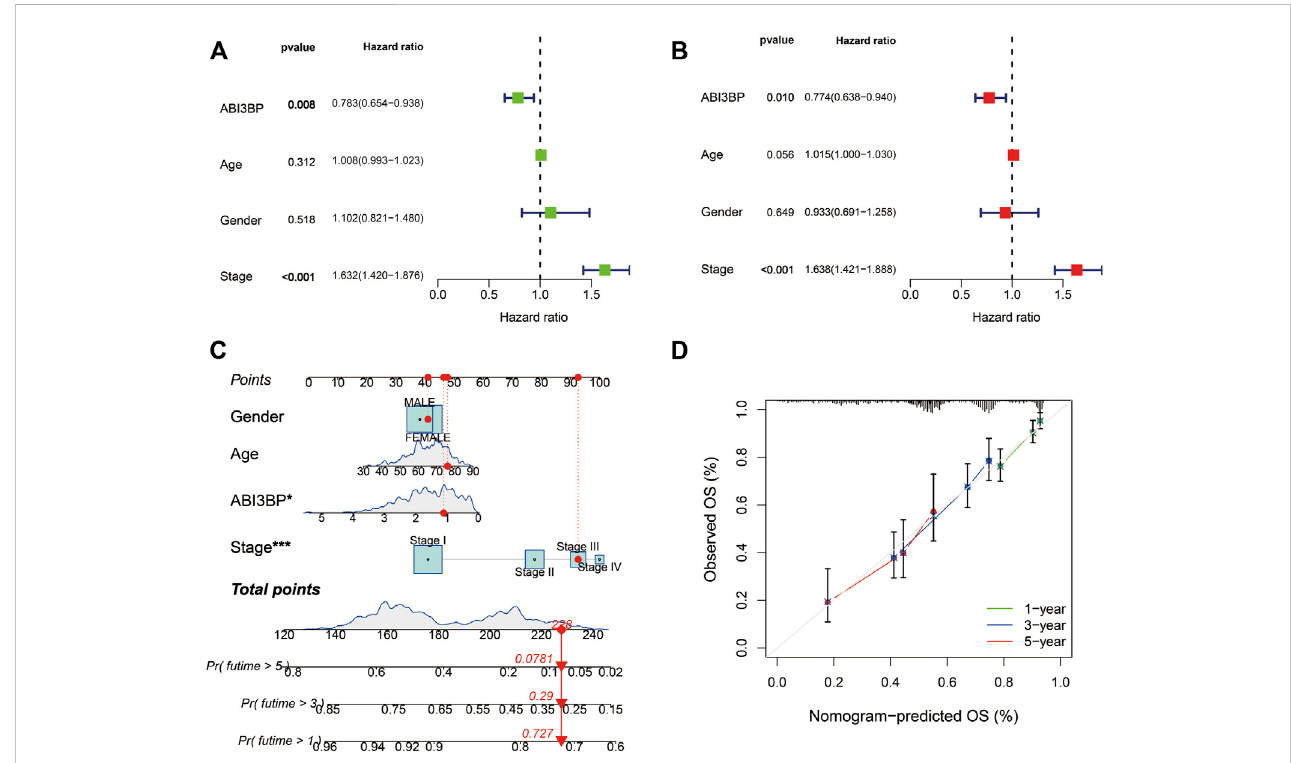
FIGURE 4 Multiple Cox regression and Nomogram construction in lung cancer patients. (A, B) Univariate and multivariate regression analysis of ABI3BP. (C, D) Construction and veri fi cation of nomogram for predicting 1-year, 3-year, and 5-year OS in lung cancer patients based on ABI3BP